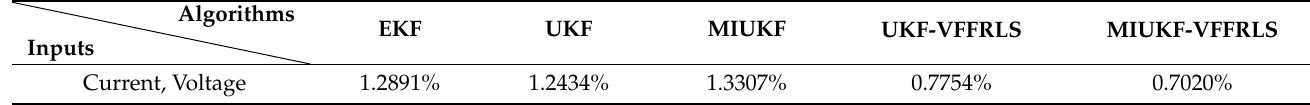
Table 4. The RMSE of Kalman filtering framework